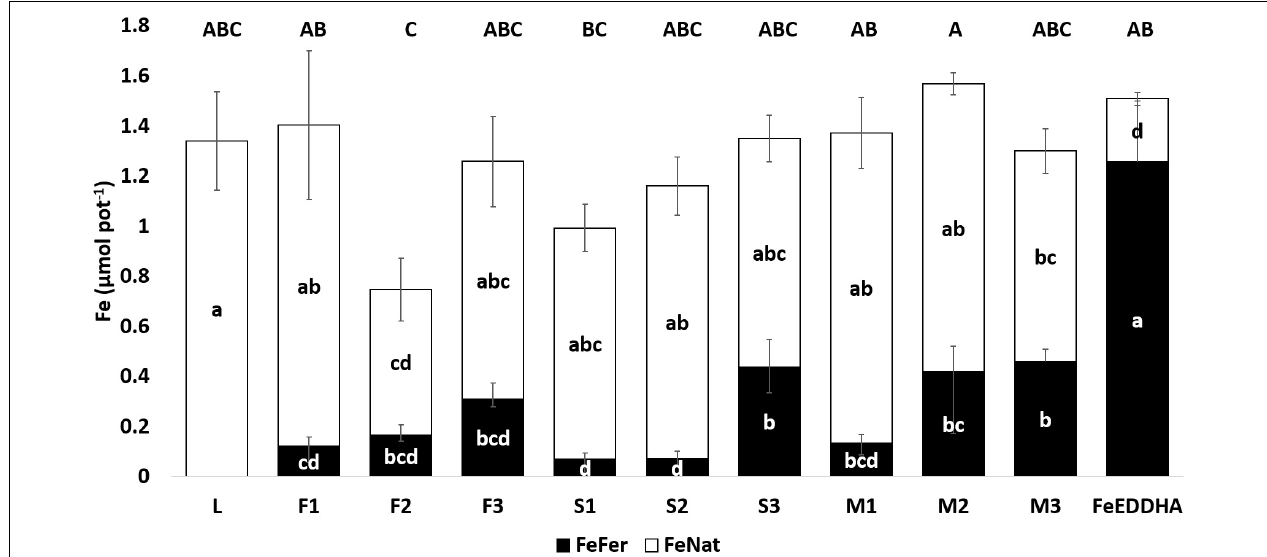
FIGURE 8 | Fe Fer and Fe Nat ( µ mol pot − 1 ) contents in soybean pods of control plants (L) and plants fertilized with the 57 Fe products F, S, and M in three doses: (1) 35, (2) 75, and (3) 150 µ mol 57 Fe pot − 1 or 50 µ mol 57 FeEDDHA pot − 1 at 48 DAF. For each series different letters denote significant differences among the treatments according to Duncan’s Test ( p < 0.05). Lowercase letters correspond to Fe Fer and Fe Nat and capital letters correspond to Fe Total statistical results. Results are expressed as averages ± standard error, n =